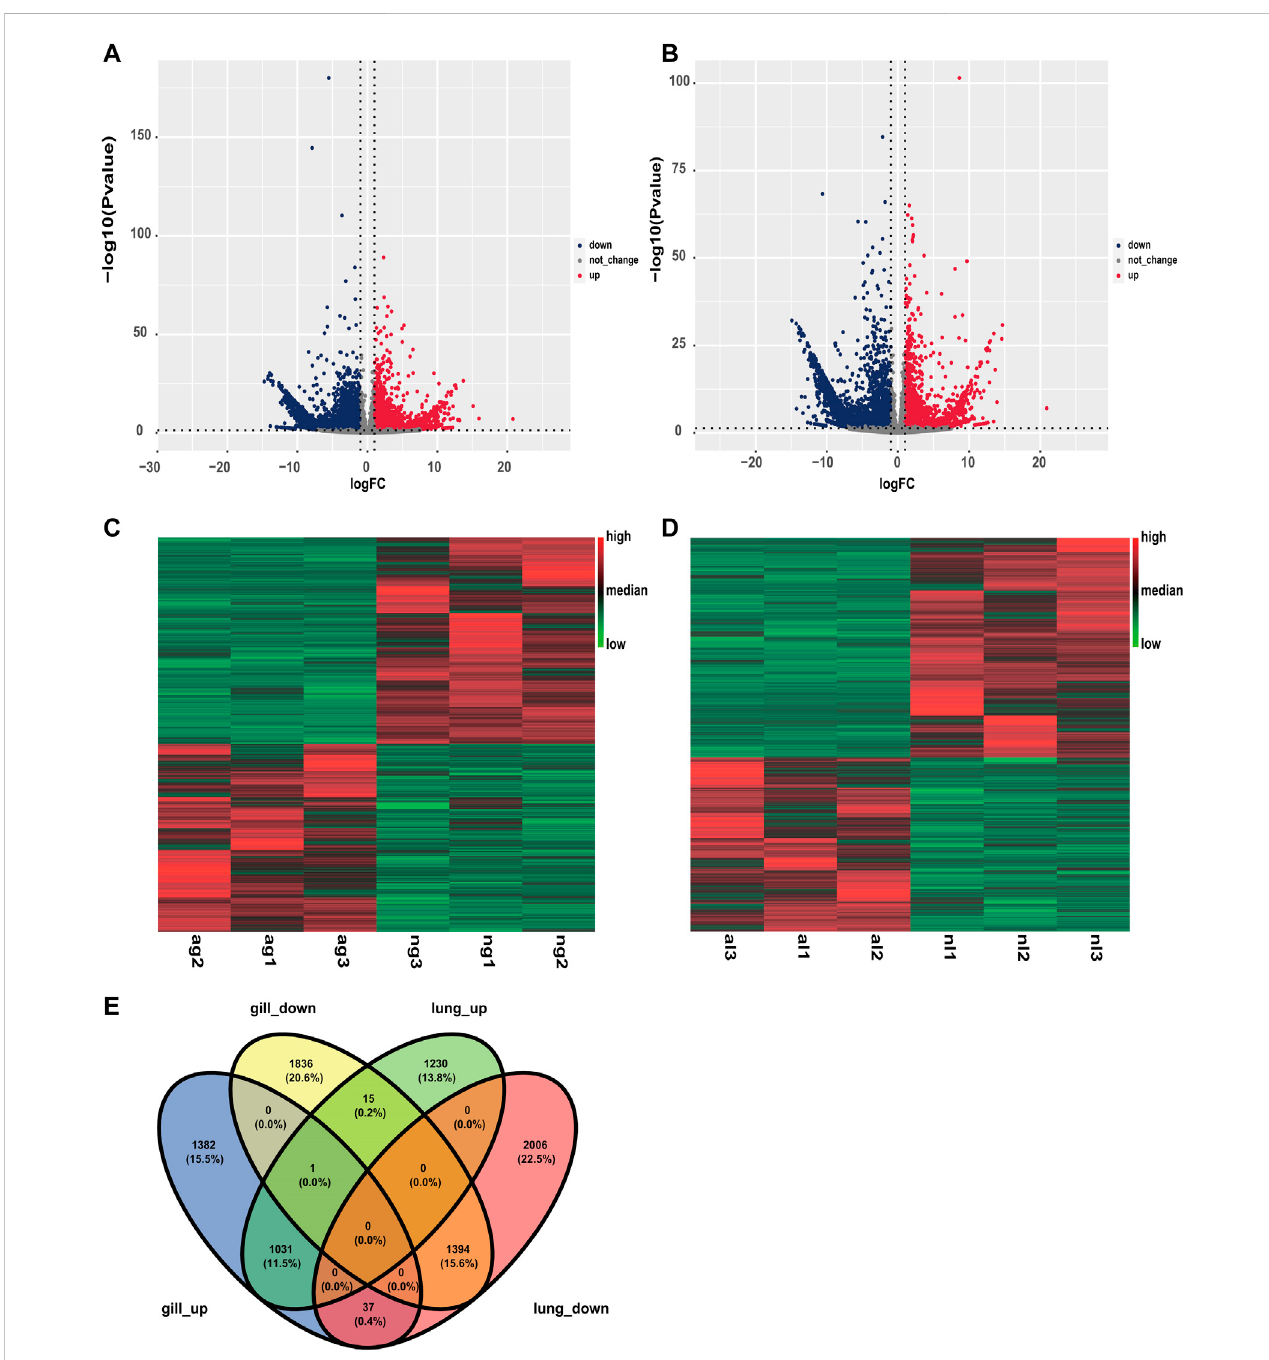
FIGURE 2 Differences in expression in the organs of aestivating African lung fi sh. (A) Volcano map of differentially expressed transcripts in the gills of aestivating lung fi sh. (B) Volcano map of differentially expressed transcripts in the lungs of aestivating lung fi sh. (C) Heat map of differentially expressed transcripts in the gills of aestivating lung fi sh. (D) Heat map of differentially expressed transcripts in the lungs of aestivating lung fi sh. (E) Venn map of differentially expressed transcripts in the gills and lungs of aestivating lung fi